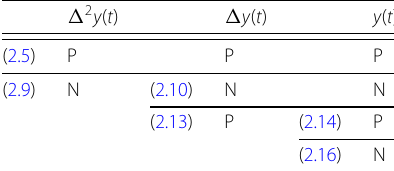
Table 1 Illustration of the proof of Lemma